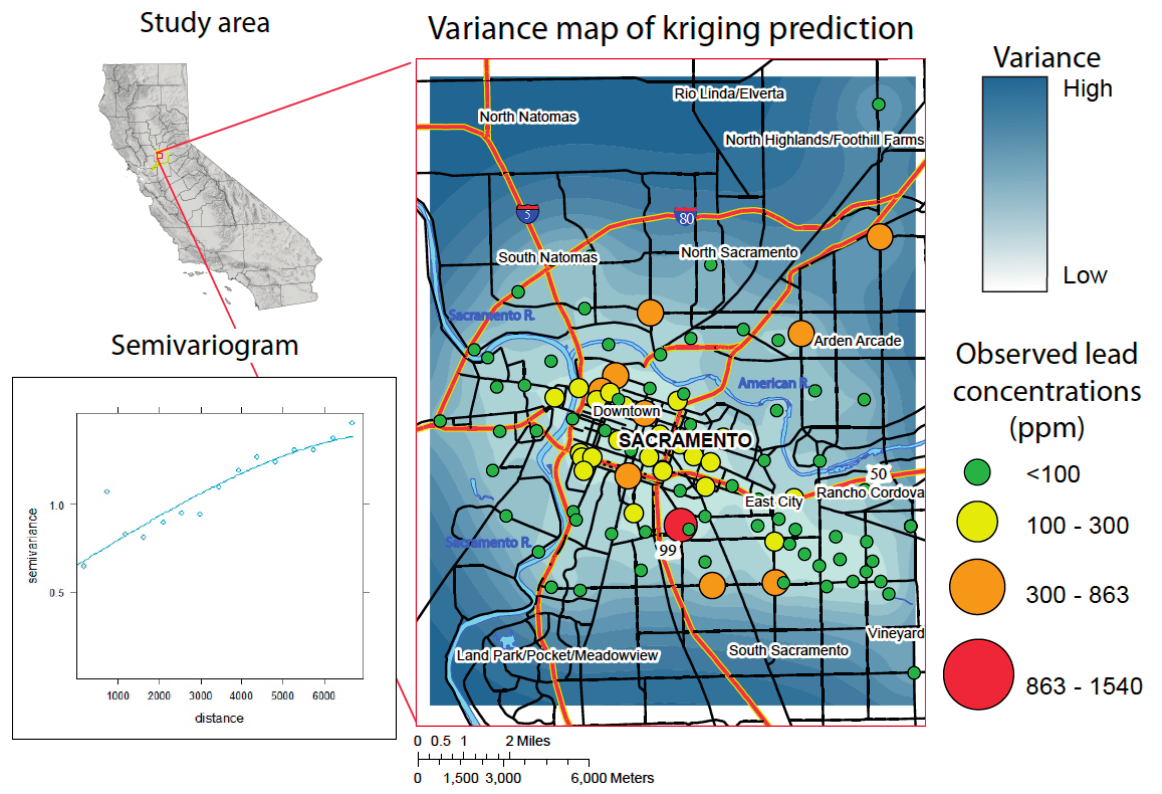
Figure 1. Map of the study area, with observed soil Pb concentrations, mapped variance, and the associated semivarigram. The semivariogram indicates that differences in Pb concentration are low at small distances, and they increase with distance, confirming that the kriging method is appropriately applied. The variance map of kriging predictions displays filled contours exhibiting the difference between the predicted (kriged) surface and the observed concentration values. Variance is lowest in the central, downtown areas of Sacramento and increase outward where the sample sites are more isolated. It is apparent that observed values at sample sites with nearby neighbors are more likely to match the predicted